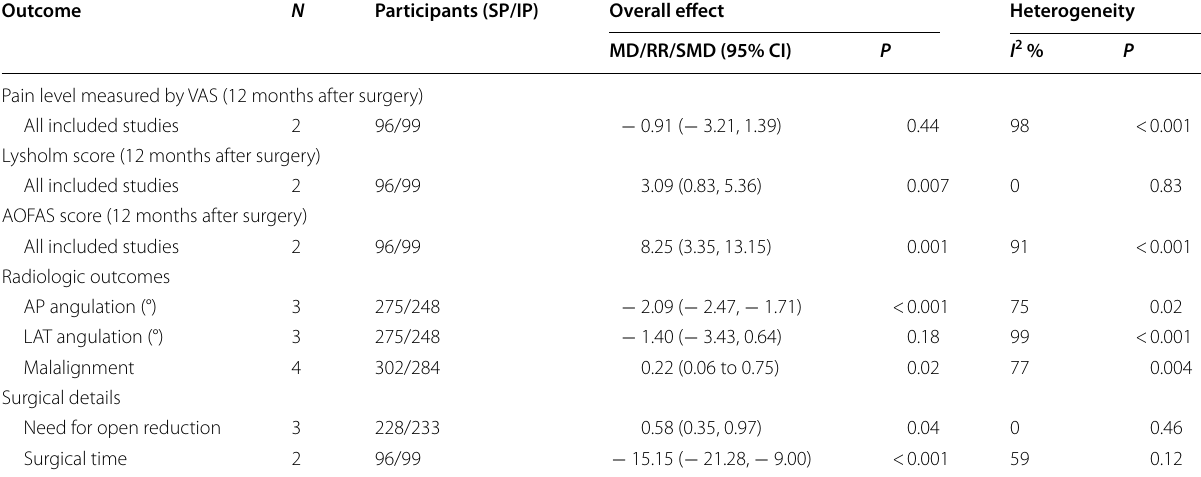
Table 3 Summary of findings